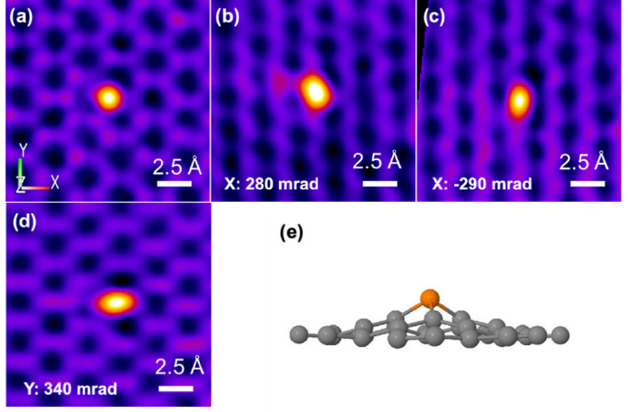
Figure 1. ( a – d ) Atomically resolved STEM of P-graphene with different angles along the X-axis and Y-axis ( e ) The experimental three-dimensional model of P-graphene. Reproduced with permission from [32]. Copyright © 2022, American Chemical Society.